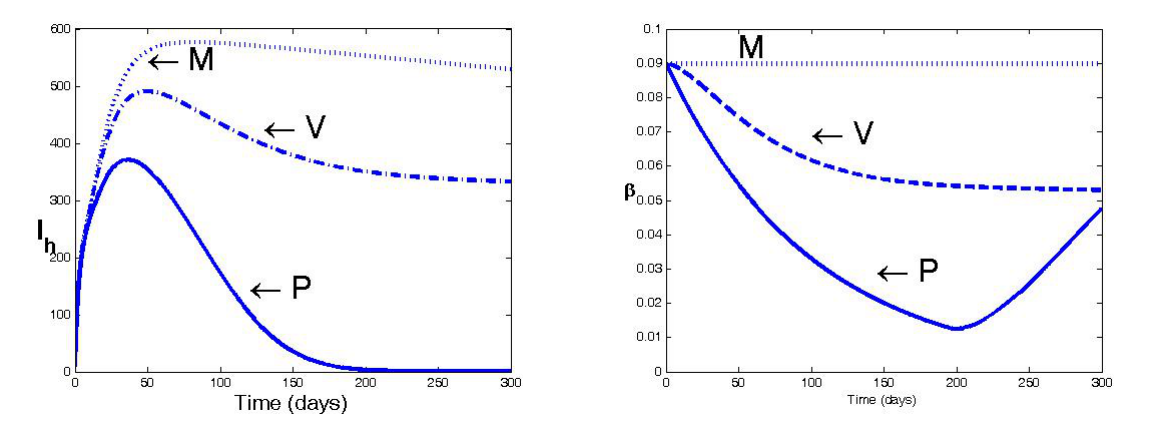
Predictions by Model M, Model V and by the optimal strategy implemented on Model P. Panel A: Infectious humans. Panel B: contact rate. We use the parameter values given in Table 1, except that β = 0 . 09 and η = 0 . 0524 . Furthermore, ξ = 0 . 01 , γ = 0 . 01 . The cost weights are A = 1 , B = 10 . The initial data are ( N h 0 , I h 0 , S v 0 , I v 0 , w 0 ) = (910 , 10 , 4000 , 1000 , 0) .